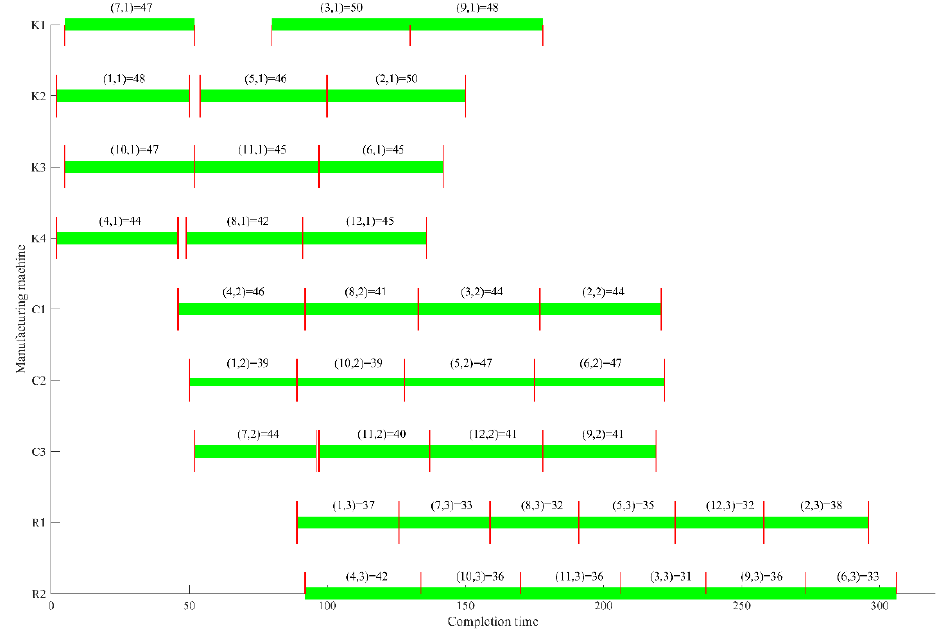
Figure 7 : Optimal schedule from the proposed ILCA.